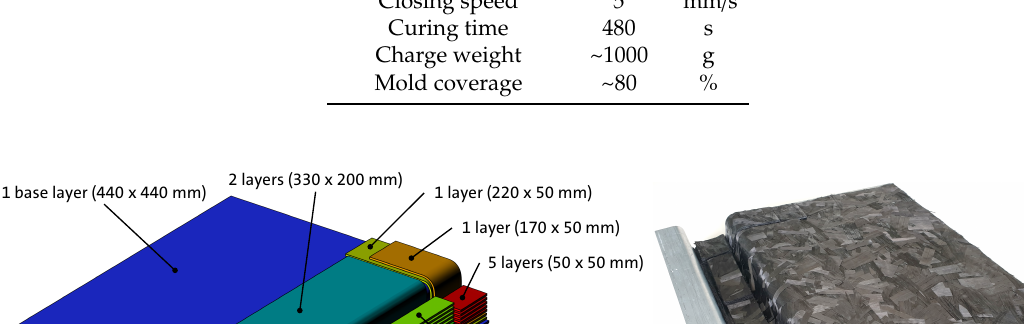
Table 2. Compression molding processing conditions.